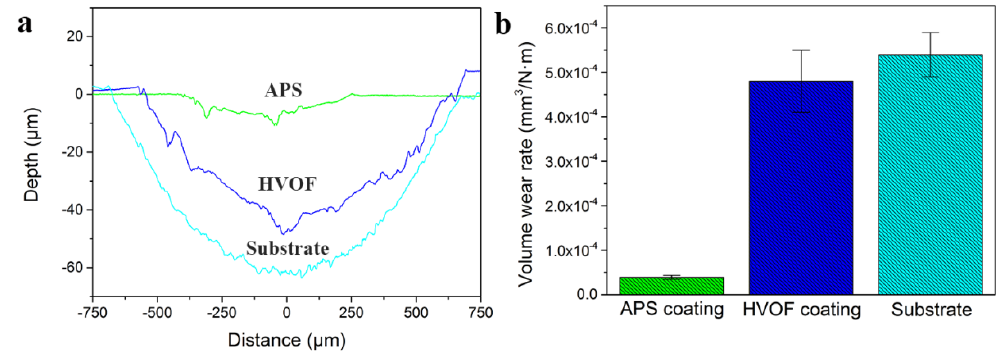
Figure 9. ( a ) The groove area measurement and ( b ) volume wear rates of the thermal-sprayed coatings.